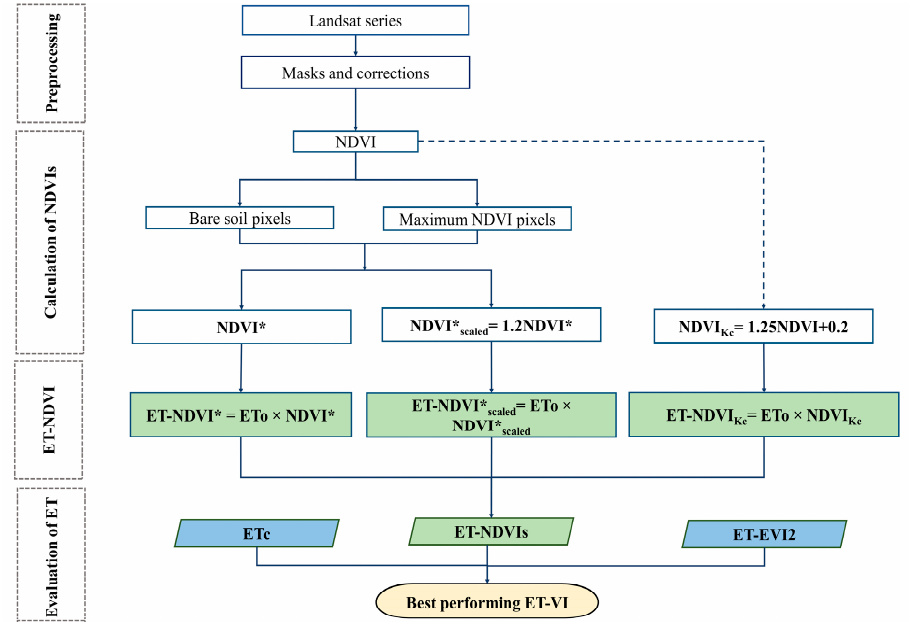
Figure 2. Workflow: green color presents the products developed in this study, blue color shows external data used in this study to assess performance of ET-NDVIs.